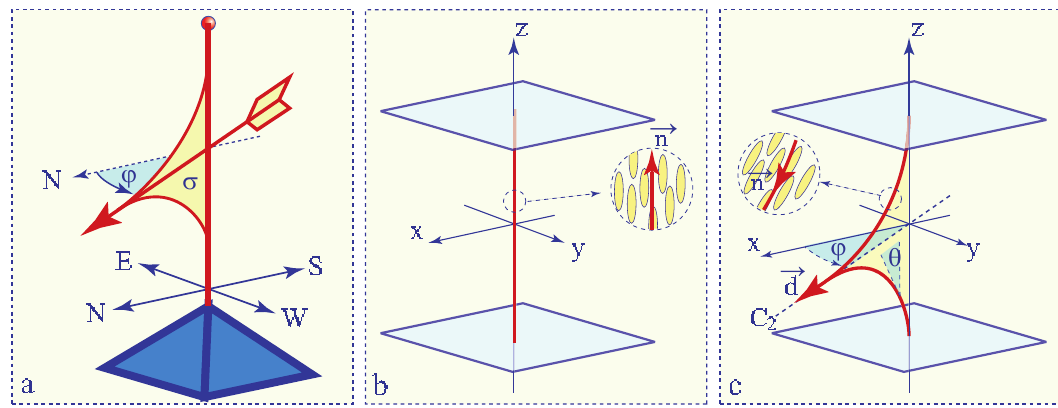
Figure 1. Sensitivity of systems with degenerated order parameters. ( a ) The azimuthal orientation of a weather vane is degenerated so that it is responsive to aerodynamic torques. ( b ) Homeotropic texture. In the absence of surfaces and fields, orientation of the director field n would be arbitrary. Therefore, surfaces treated for homeotropic anchoring impose easily the uniform orientation n // z . ( c ) Director field n , symmetry C 2 v and order parameter d (or ϕ ) of the dowser texture. The group C 2 v contains three symmetry elements: the twofold axis C 2 , the mirror plane σ and the mirror plane (x,y). By analogy with the weather vane, the dowser texture is sensitive in first order to fields such as a Poiseuille